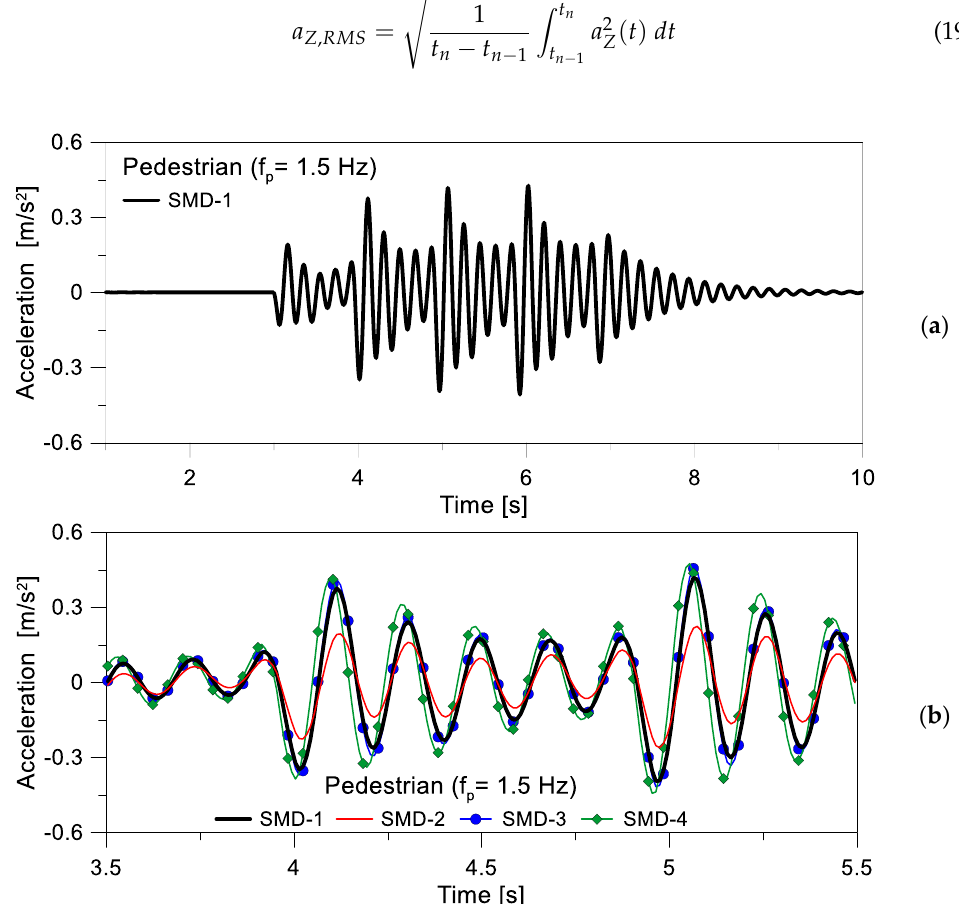
Figure 6. Example of typical dynamic response for the F#2 concrete system under normal walk ( M = 80 kg, f p = 1.5 Hz): ( a ) acceleration time history on the structure and ( b ) comparative detail (ABAQUS).